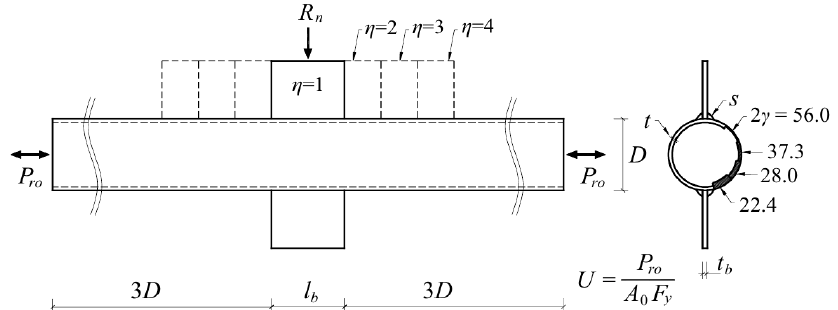
Figure 7. Parametric analysis plan of CHS XP-joints.